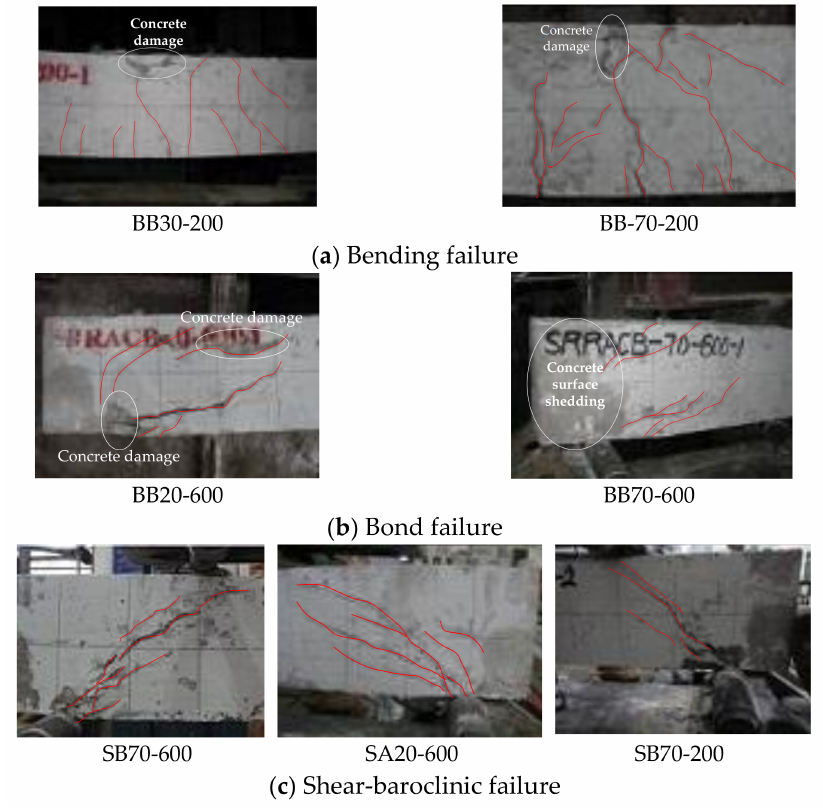
Figure 9. The failure modes of beam